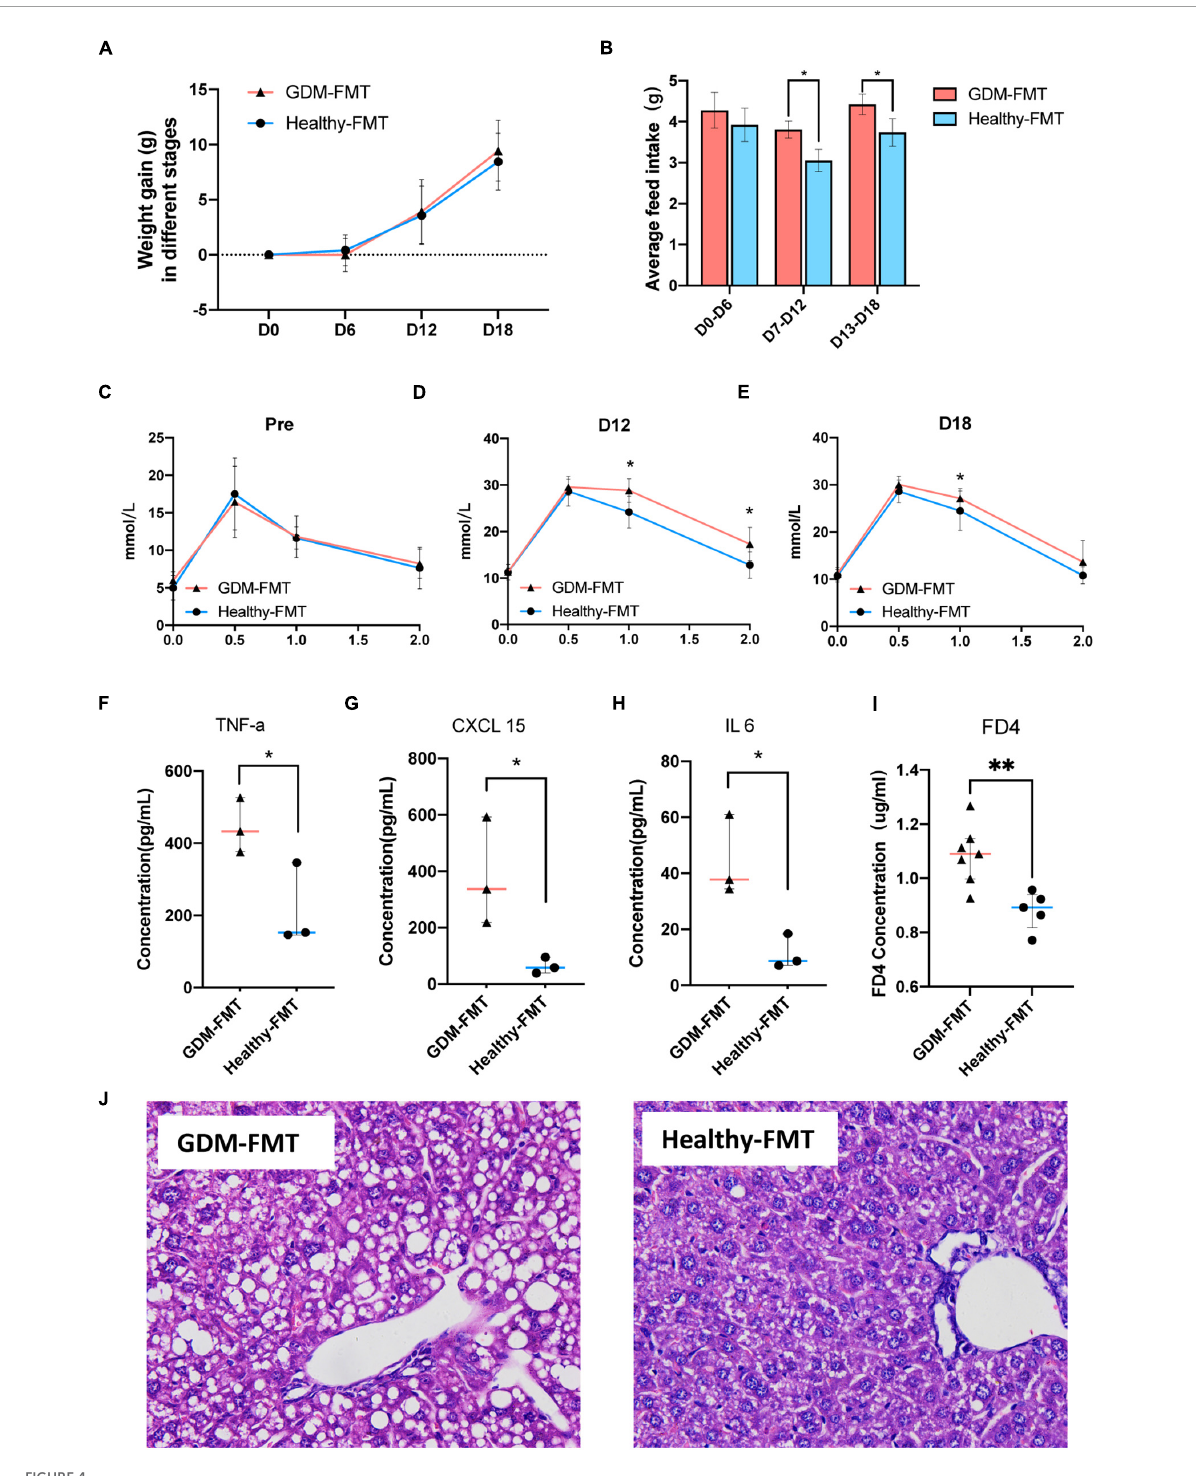
FIGURE4 Phenotypic differences between the two groups of mice. (A) The line chart shows the body weight of the two groups in different periods. (B) The barplot shows the weight gain of the two groups in different time periods. (C,E) The line chart shows the results of the IPGTT in different periods. (F–H) The scatter plot shows the levels of inflammatory factors (TNF- α , CXCL15, and IL 6) in the plasma of the two groups. The data are shown as the median and interquartile range. (I) The scatter plot shows the levels of FD4 in the plasma of the two groups. (J) The HE staining diagram of liver cells, microscope 400x field of view. * p < 0.05; ** P <